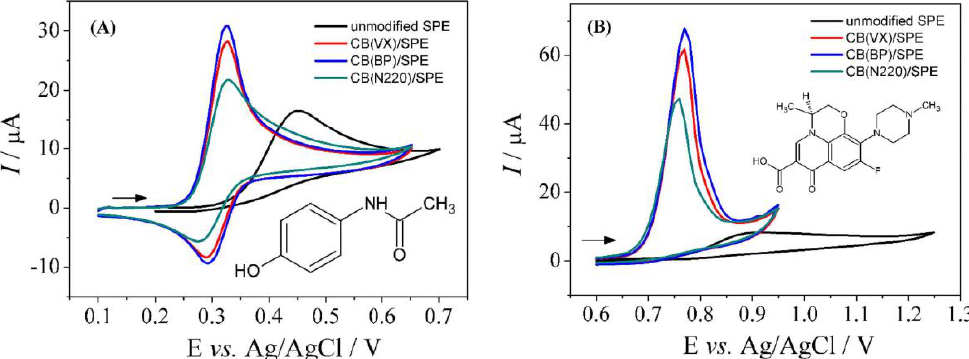
Figure 10. Cyclic voltammograms obtained from the application of the three proposed electrodes: unmodified SPE (black line); CB(VULCAN XC72R)/SPE (red line); CB(BLACK PEARLS 4750)/SPE (blue line) or CB(N220)/SPE (green line) for ( A ) 5.0 × 10 −4 mol L −1 acetaminophen and ( B ) 1.0 × 10 −4 mol L −1 Levofloxacin, in 0.2 mol L −1 phosphate buffer solution (pH 3.0), at scan rate ( v ) = 50 mV s −1 . Reprinted with permission from Wiley from Ref. [147].